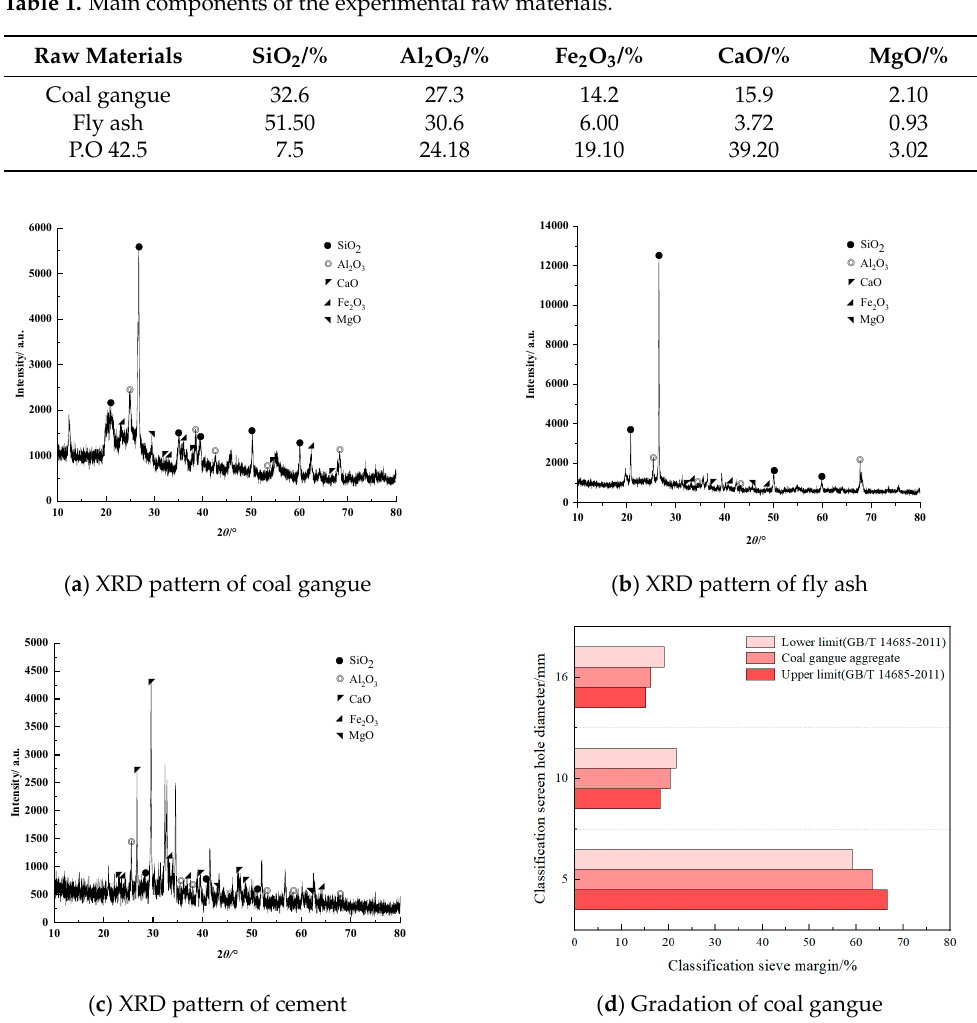
Figure 1. XRD patterns of raw materials and particle size distribution of coal gangue.